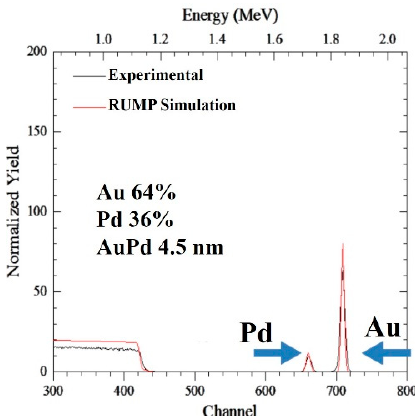
Figure 1. Representative Rutherford backscattering analysis (RBS) spectrum: black line, experimental spectrum; red line, RUMP simulation. Spectrum refers to a Au / Pd film deposited on reference Si substrate. Peaks corresponding to corresponding to presence of Au and Pd are indicated. Simulation of experimental spectrum indicates an atomic composition of 64% Au and 36% Pd film. Correspondingly, an e ff ective thickness for the Au / Pd film of 4.5 nm was evaluated in this